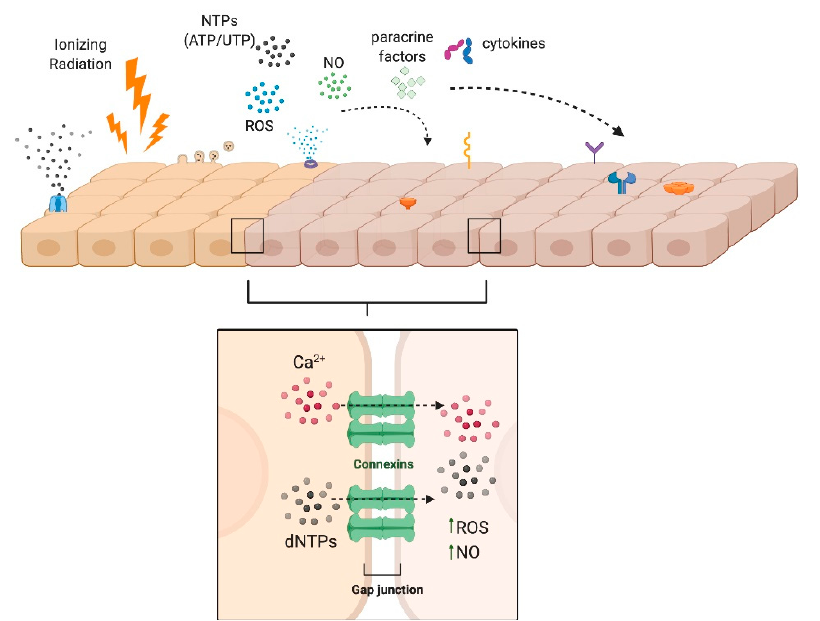
Figure 2. Radiation-Induced Bystander Effects. The bystander effect can be propagated by intercellular communication between adjacent cells via gap junctions or by autocrine or paracrine signaling processes whereby NTPs, nitric oxide (NO), reactive oxygen species (ROS), cytokines (e.g. , TGF- β ), or other second messengers elicit a response in non-irradiated cells. Created with Biorender.com.